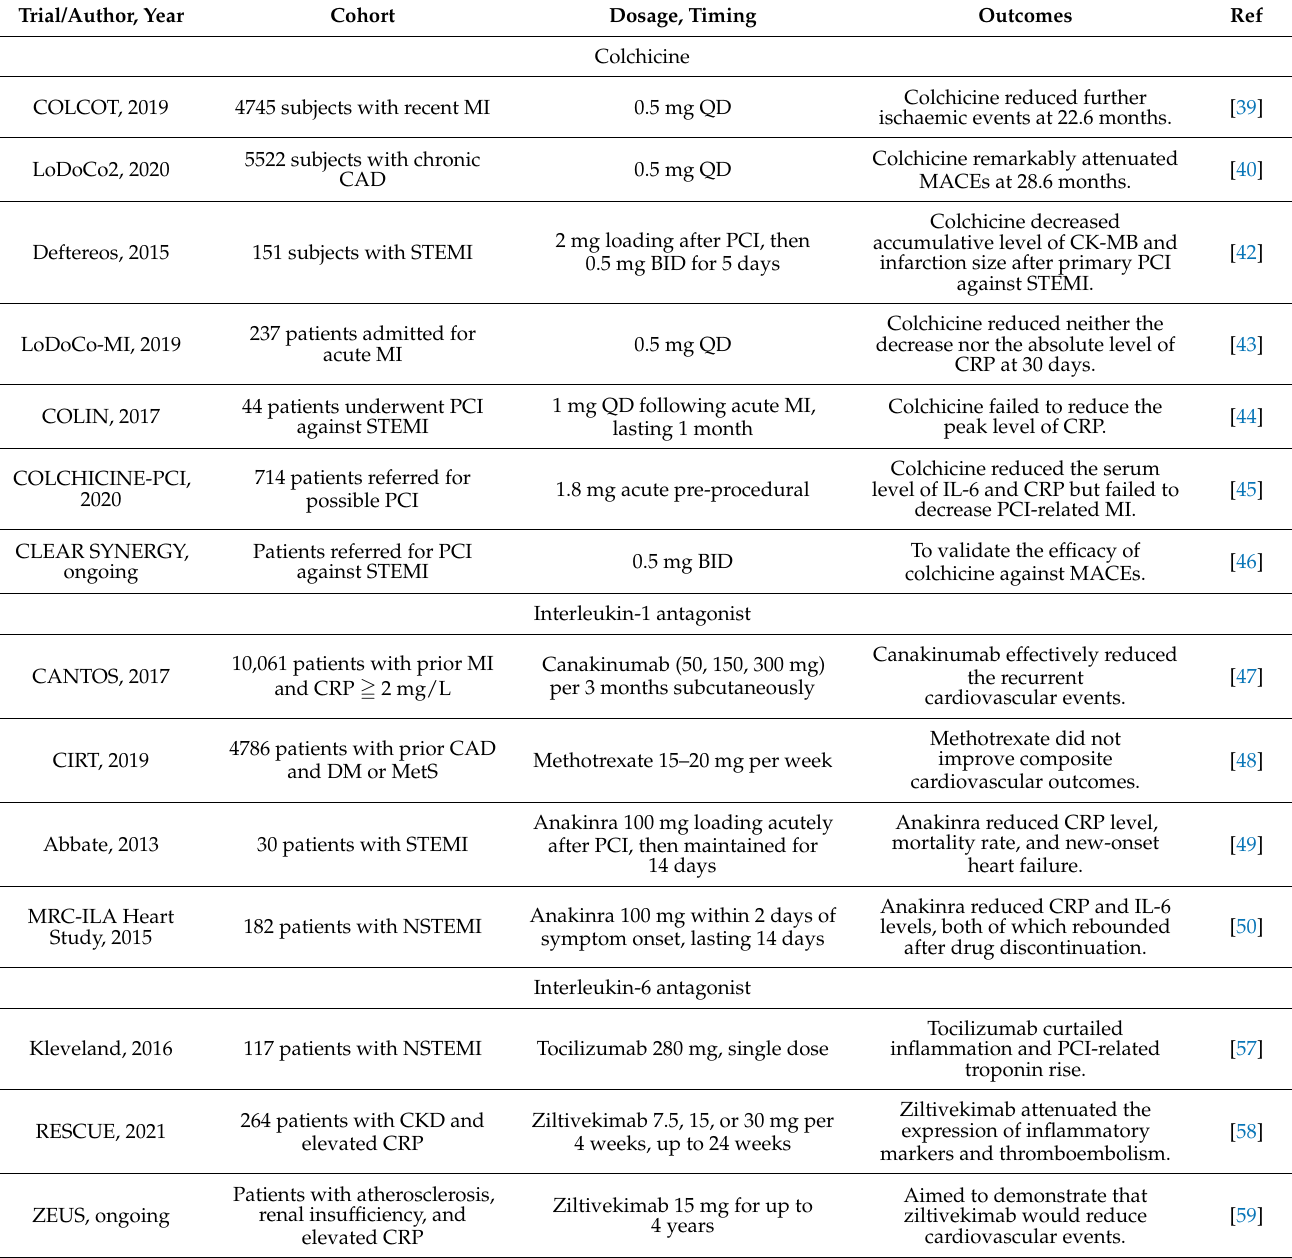
Table 1. Pharmaceutical management of inflammatory status and corresponding cardiovascular